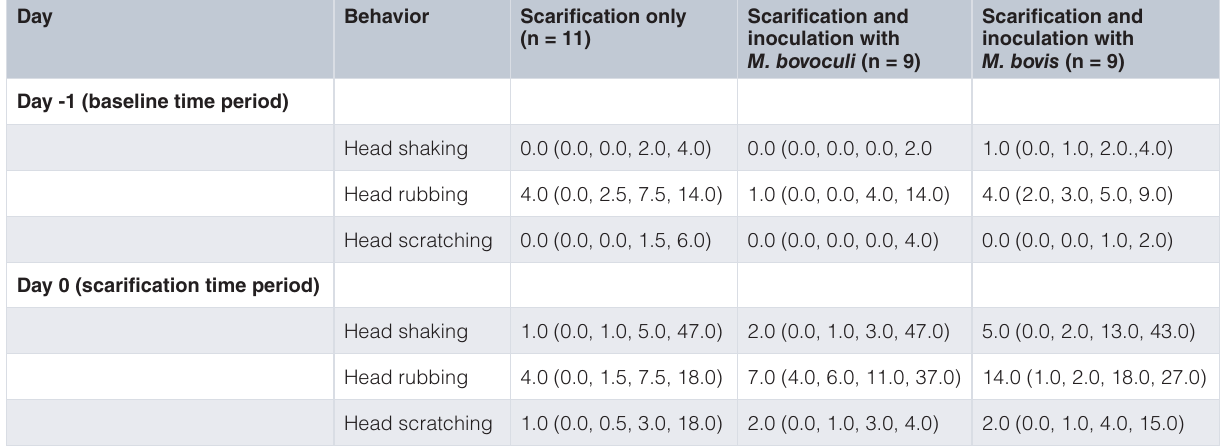
Table 2. Median (minimum, 25 th percentile, 75 th percentile, maximum) values of frequency of events for head shaking, head rubbing and head scratching by treatment over five hour observation periods during baseline and scarification time periods (n = number of calves